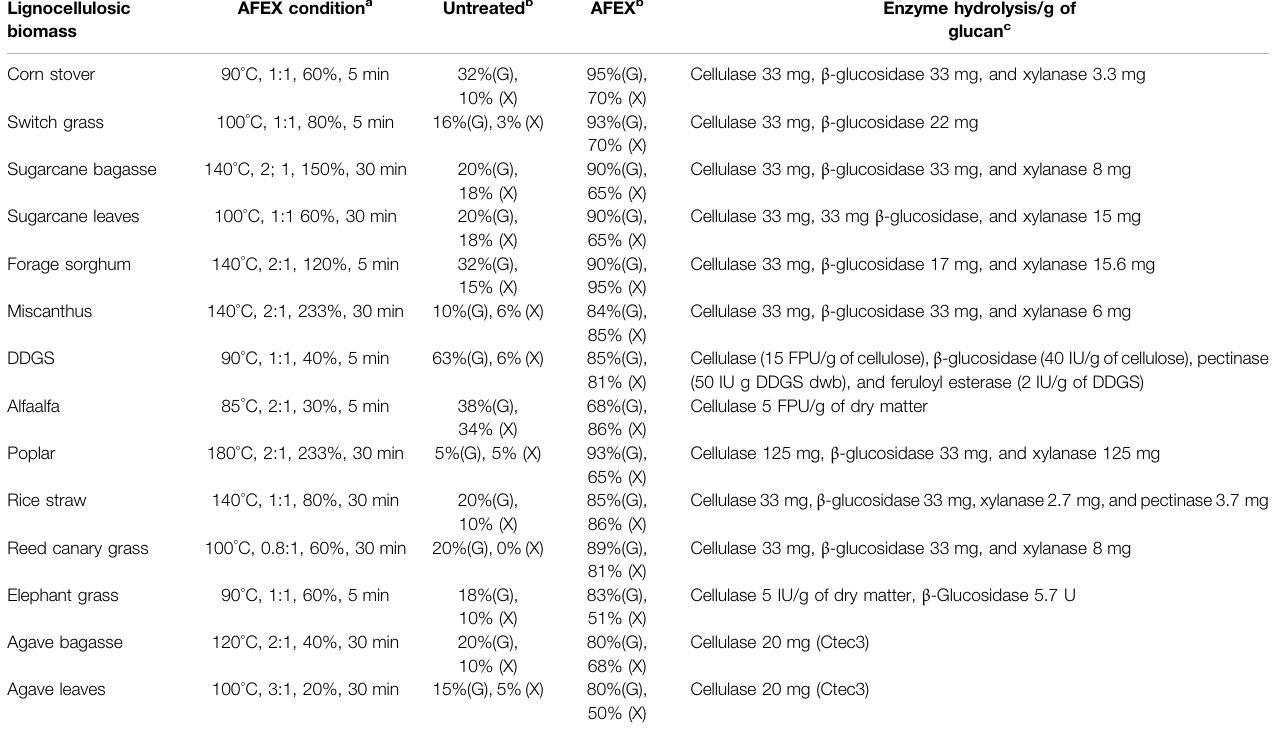
TABLE 1 | Sugar conversion of lignocellulosic biomass before and after AFEX pretreatment. Lignocellulosic